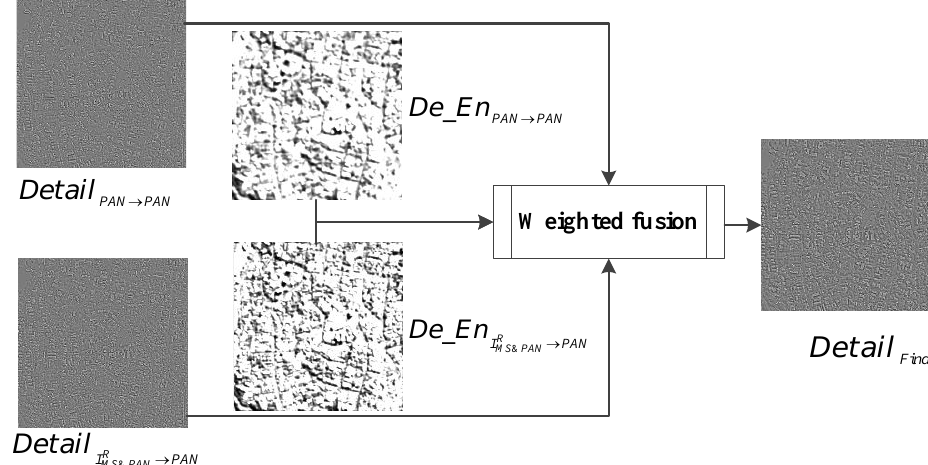
Figure 10. The flow chart of final texture details information.